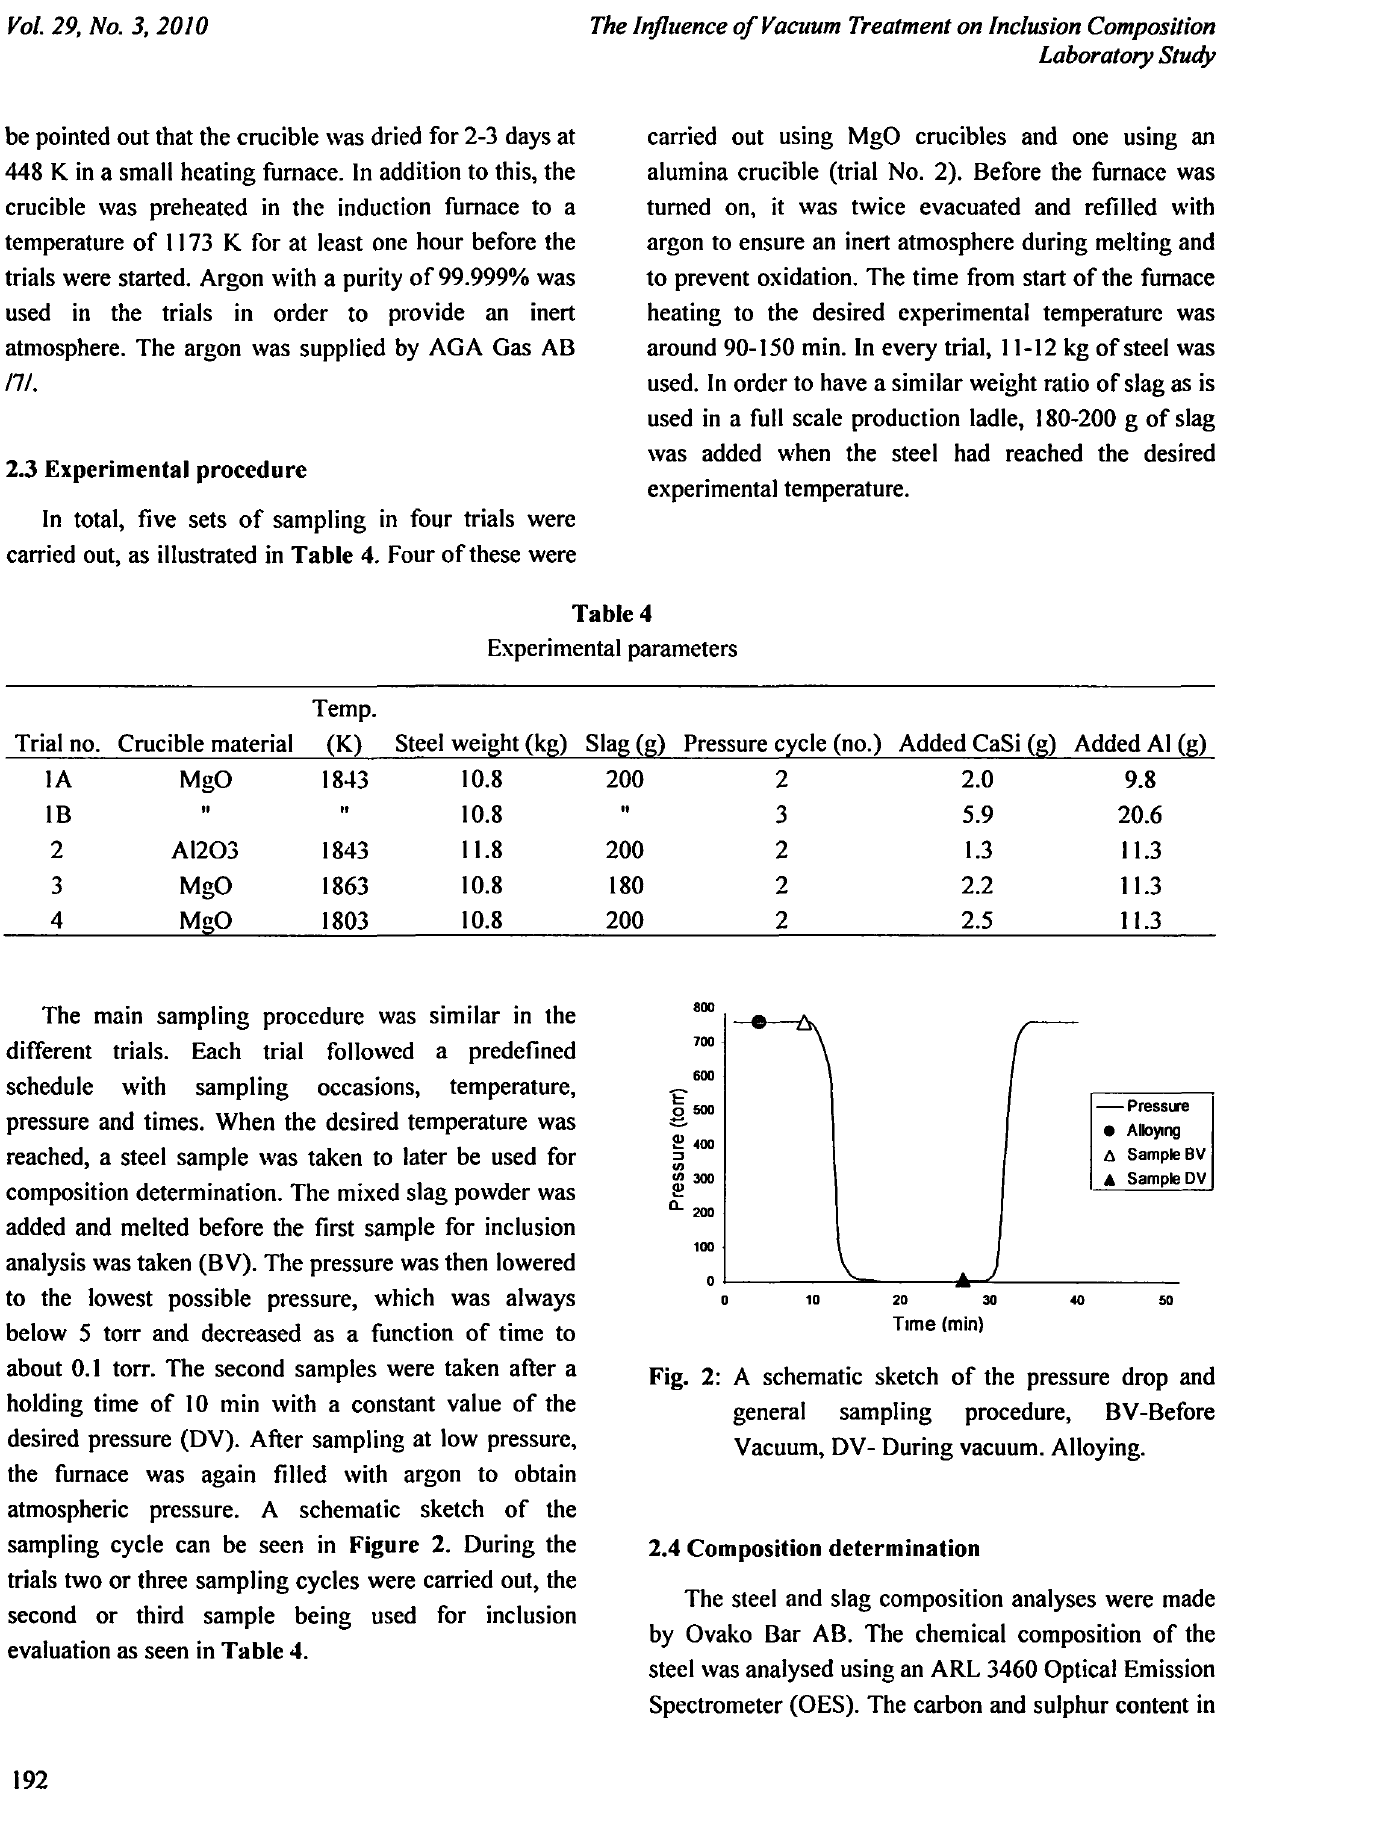
Fig. 2: A schematic sketch of the pressure drop